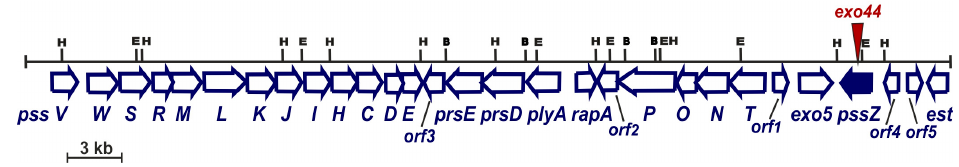
Figure 2. Physical and genetic map of the Pss-I region of R. leguminosarum Rt24.2. Arrows below the map indicate the direction of gene transcription. Selected restriction sites are marked: E, EcoRI; H, HindIII; and B, BamHI. Location of the mTn 5 SS gusA 40 insertion in the mutant Rt297 genome is marked by a red triangle.